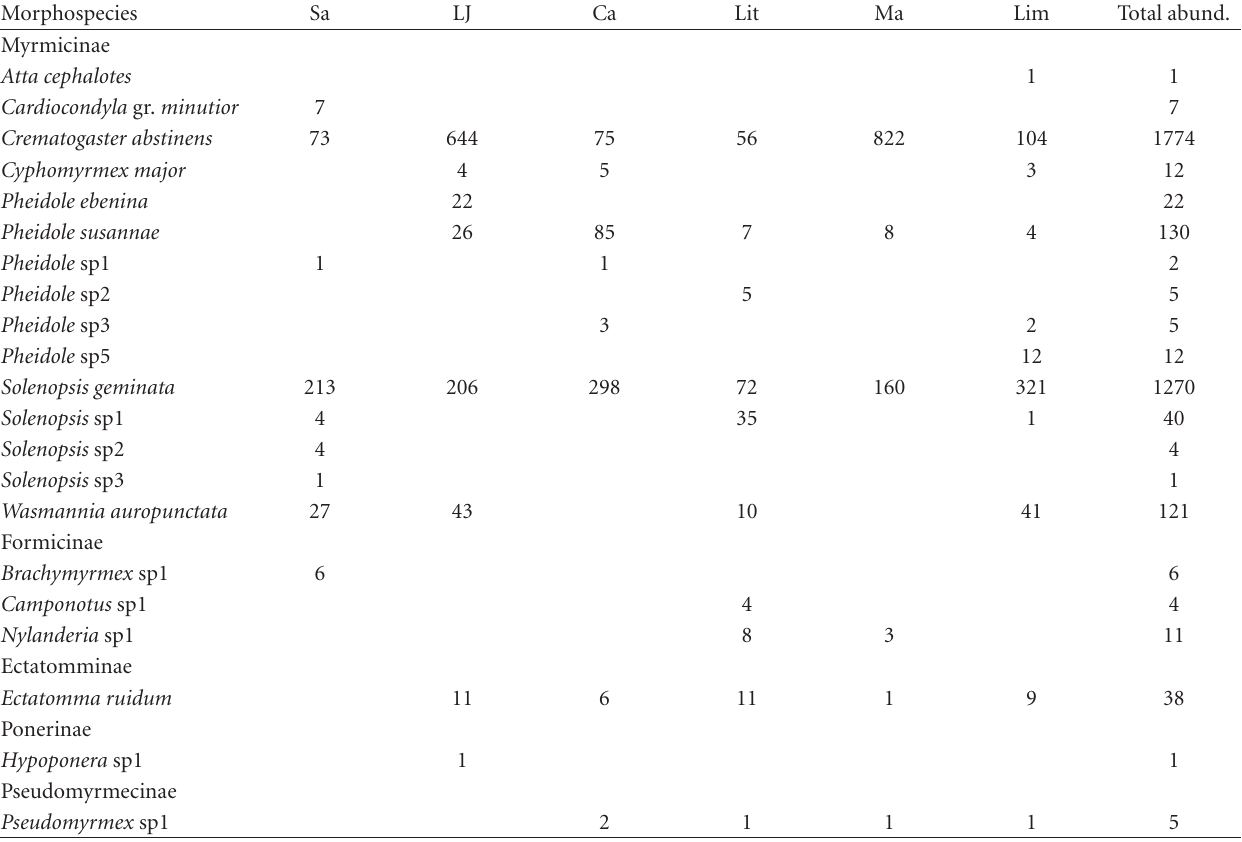
Table 1: Composition and total abundance of ant species attracted to tuna and honey baits in each locality. (Sa: Sachamate, LJ: La Josefina, Ca: Cachimbalito, Lit: Lituania, Ma: Mara˜n´on, Li: Limonar).